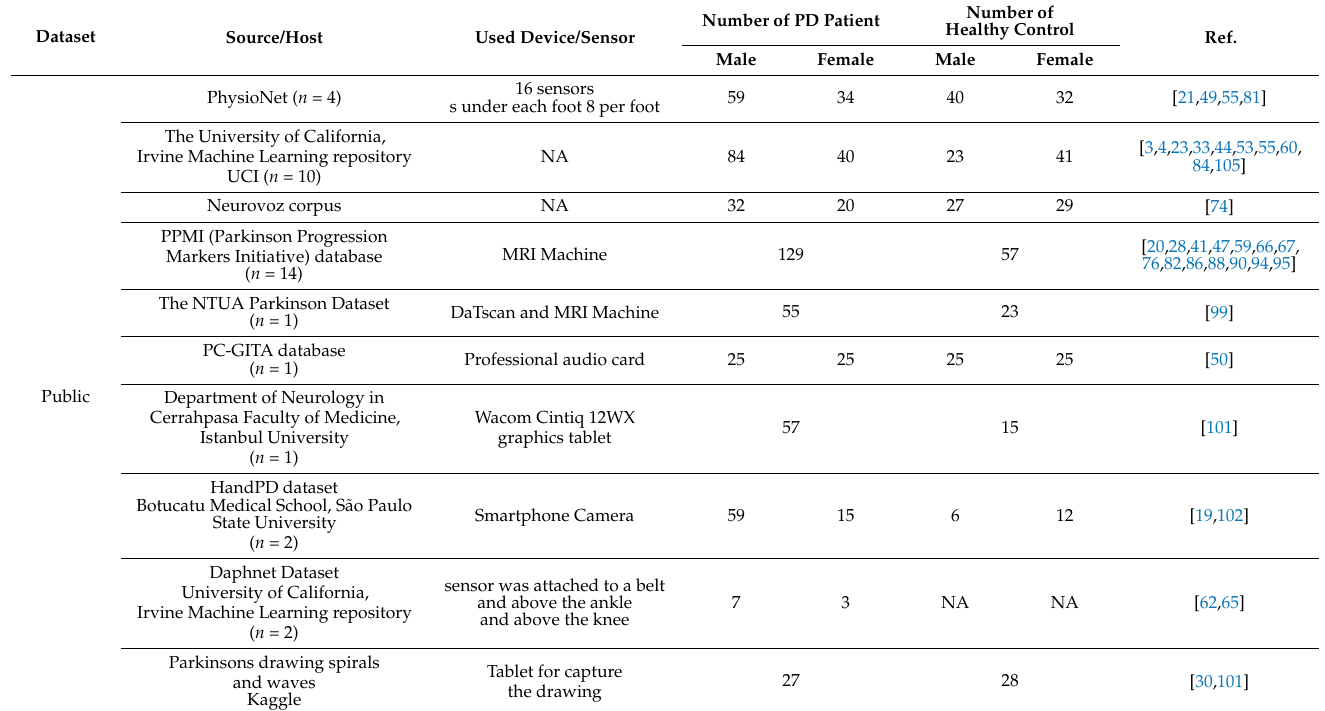
Table 4. Public dataset